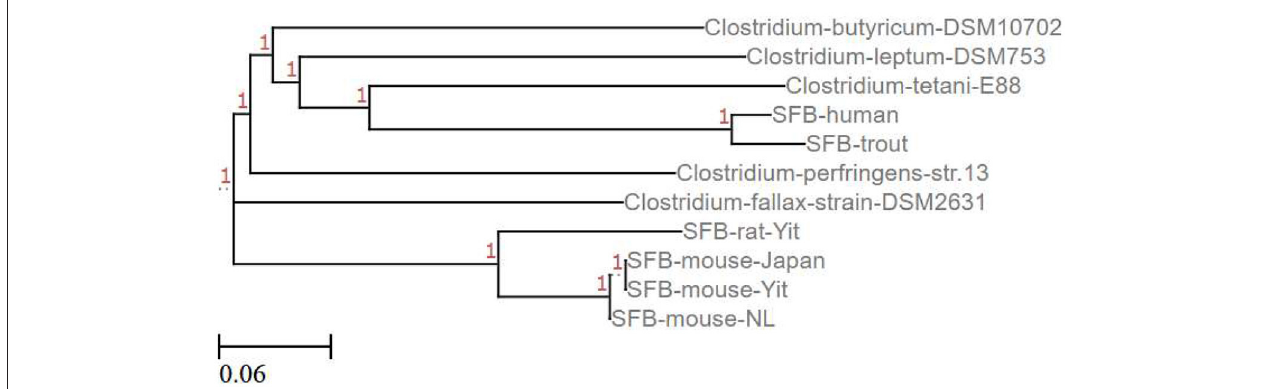
FIGURE 3 | Phylogenetic tree relating SFB to Clostridium species. This phylogenetic tree shows the relationship between complete (SFB mouse-Yit, SFB-rat-Yit, SFB-mouse-Japan, and SFB-mouse-NL) and partial (SFB-human and SFB-trout) SFB genomes and some pathogenic (C. perfringens, C. fallax, and C. tetani) and non-pathogenic (C. butyricum and C. leptum) Clostridium species published in the NCBI database (Created using the EMBL-EMI Multiple Sequence Alignment Clustal Omega tool and ETE toolkit-Phylogenetic Tree viewer).